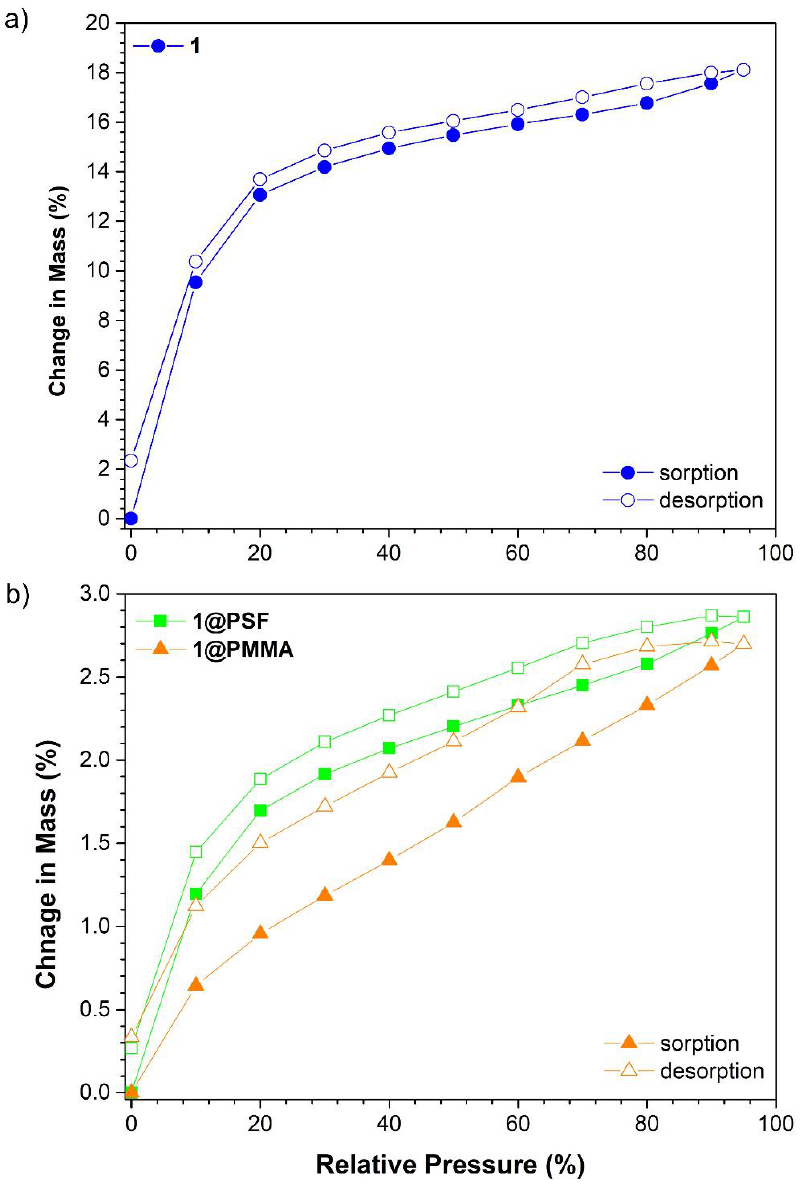
Figure 5. Water vapour adsorption (solid symbols) and desorption (open symbols) isotherm curves for ( a ) compound 1 , and ( b ) 1@PSF and 1@PMMA membranes .